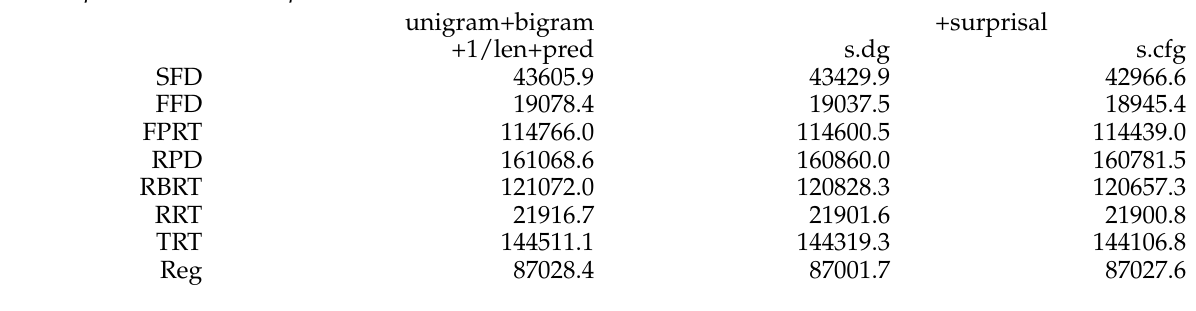
Deviance Information Criterion values for the simpler model, which includes only the word-based statistical measures, and the more complex model, with surprisal added.